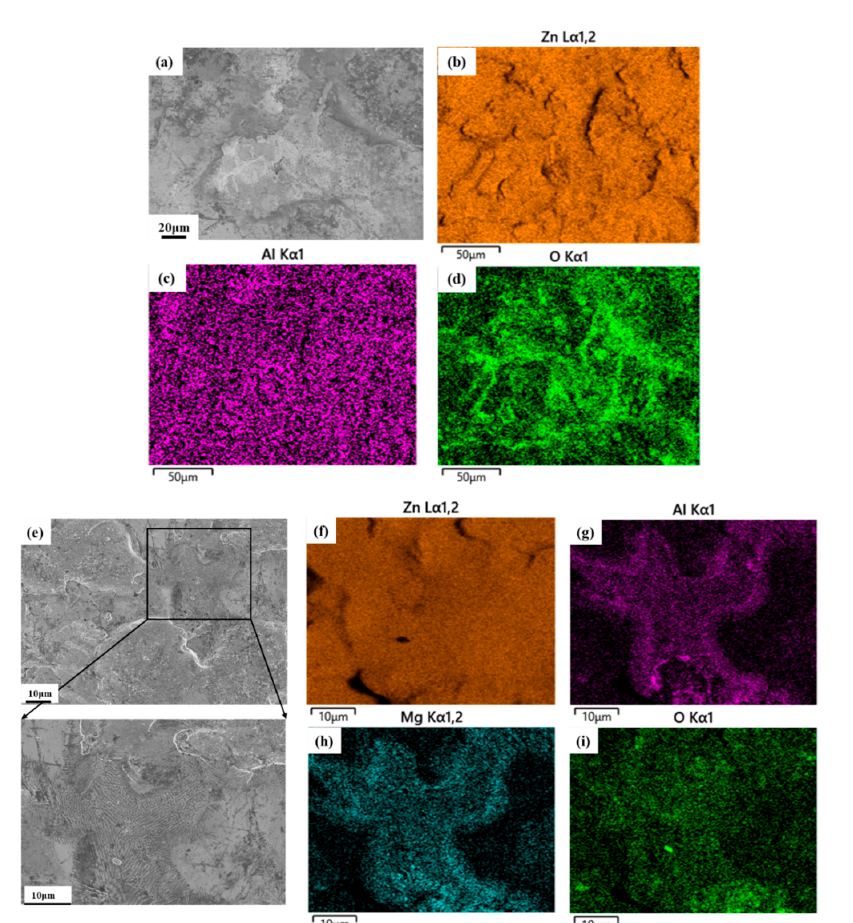
Figure 4. SEM micrographs and EDS maps of elements acquired on ( a – d ) Zn–Al and ( e – i ) Zn–Al–Mg coating surfaces.